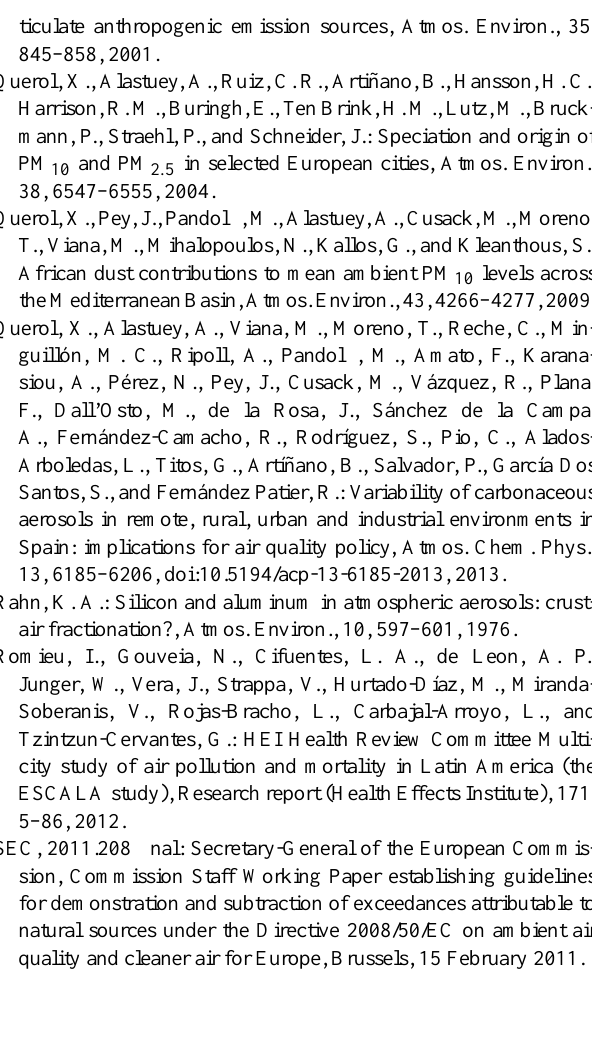
for demonstration and subtraction of exceedances attributable to natural sources under the Directive 2008/50/EC on ambient air quality and cleaner air for Europe, Brussels, 15 February